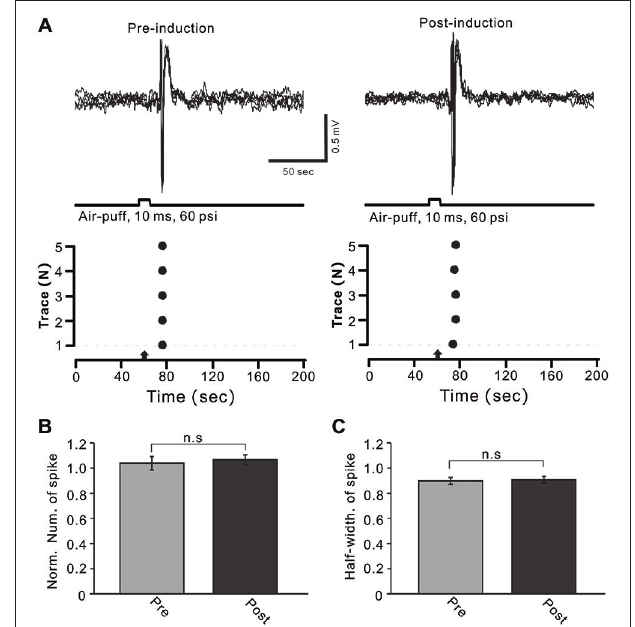
FIGURE 4 | LTD of sensory-evoked P1 at PCs was accompanied with a decrease in the pause of SS firing. (A) Bar graph showing normalized pause of SS firing before (pre) and after (post) delivery of 1 Hz (240 pulses) stimulation. (B) Pooled data showing normalized pause of SS firing before (pre) and after (post) delivery of 2 Hz (240 pulses) stimulation. (C) Summary of data showing normalized values of the pause before (pre) and after (post) delivering 4 Hz (240 pulses) stimulation. (D) Bar graph showing normalized pause firing values under control conditions (without train of facial stimulation). Note that the amplitude of the pause of SS firing was decreased after 1 Hz stimulation, but not after 2 Hz or 4 Hz stimulation. ( Figure 1B ). Under cell-attached recording conditions, cerebellar